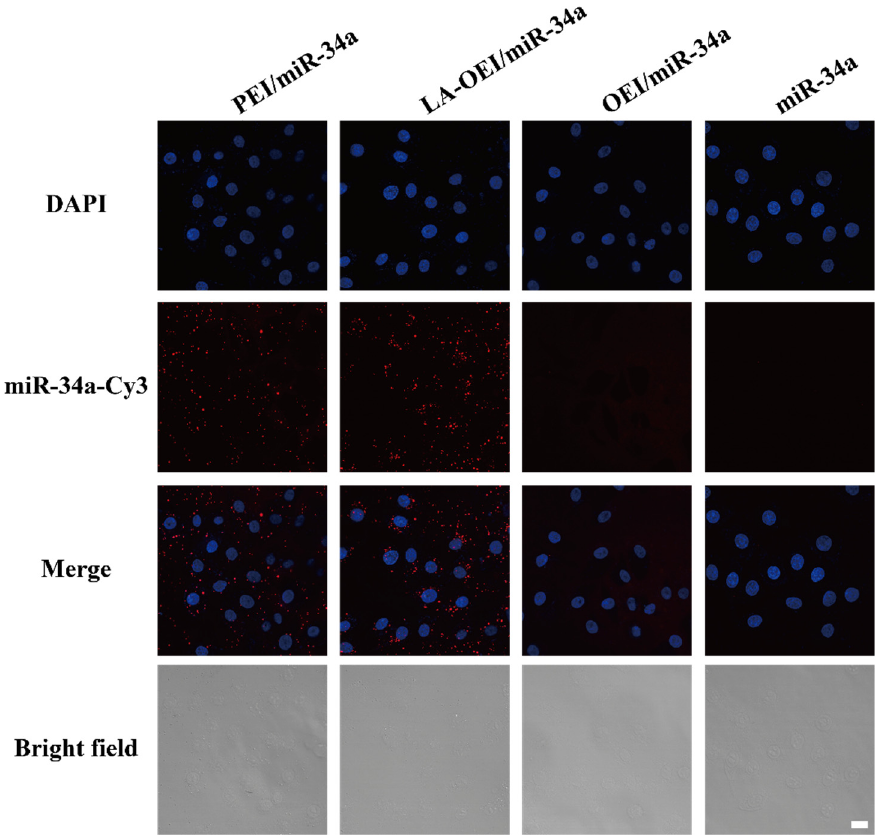
Figure 2. The transfection efficiency analysis of free miR-34a, PEI/miR-34a, LA-OEI/miR-34a and OEI/miR-34a nanoparticles in HeLa cells through CLSM images. The scale bar is 20 μ m.